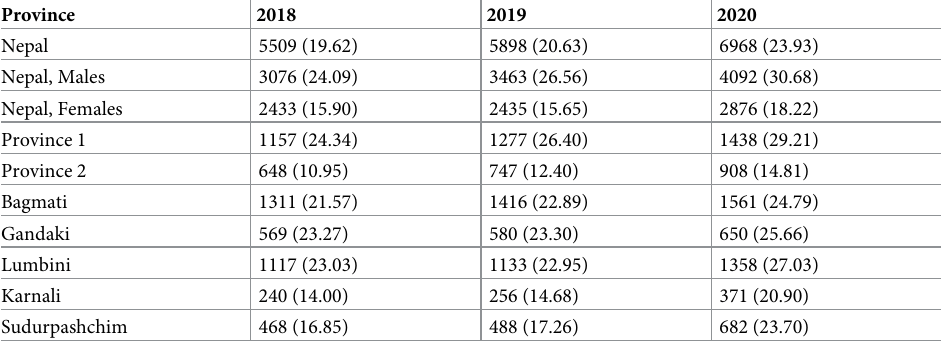
Table 1. Country and province-level annual suicides numbers (annual suicide rates per 100,000